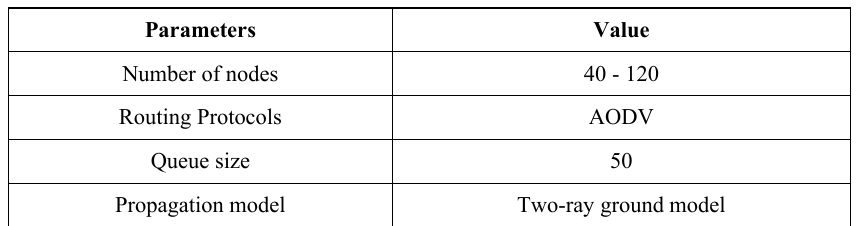
Table 1. Simulation parameters.